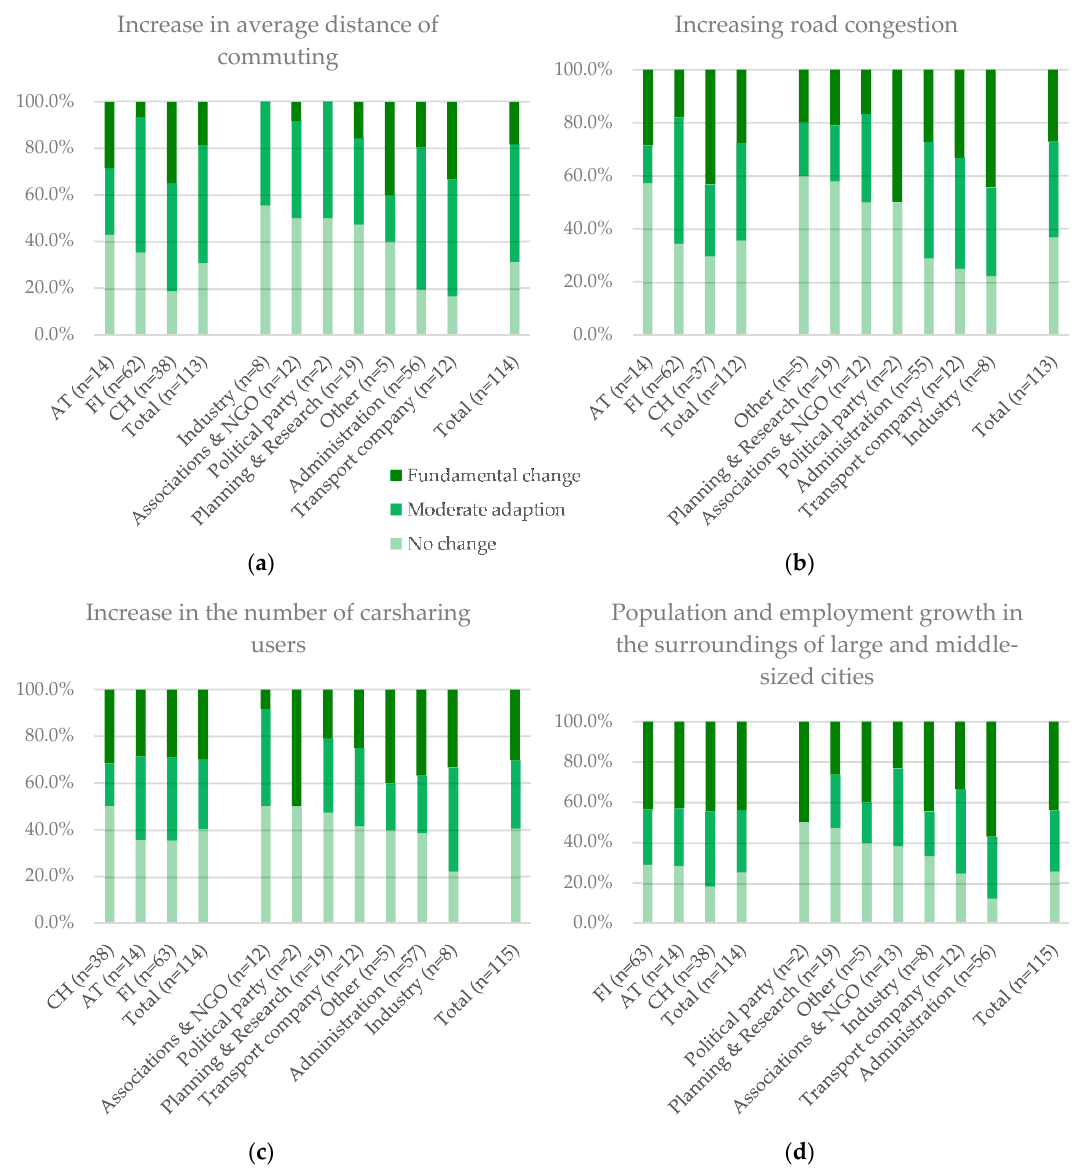
Figure 1. Stakeholder’s estimation of the impact of four trends ( a – d ) on their way of work and their strategies in the area of commuting. Data: ZHAW, Aalto University, tbw research.